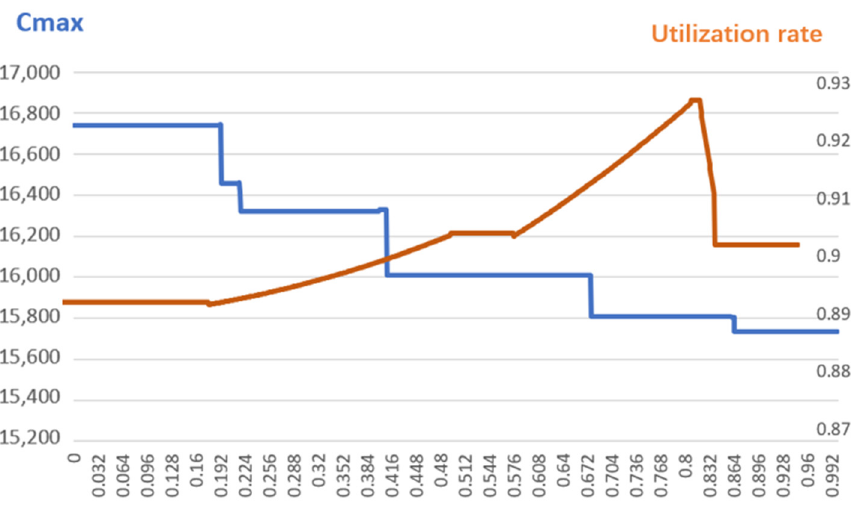
Figure 8. Optimized Curve of the Acceptance Factor for Case MK10.